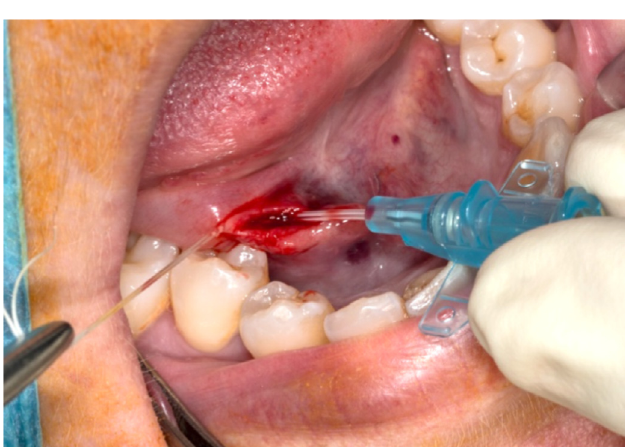
Fig. 15. Clinical view of a catheter placed into the lumen of Wharton ’ s duct.